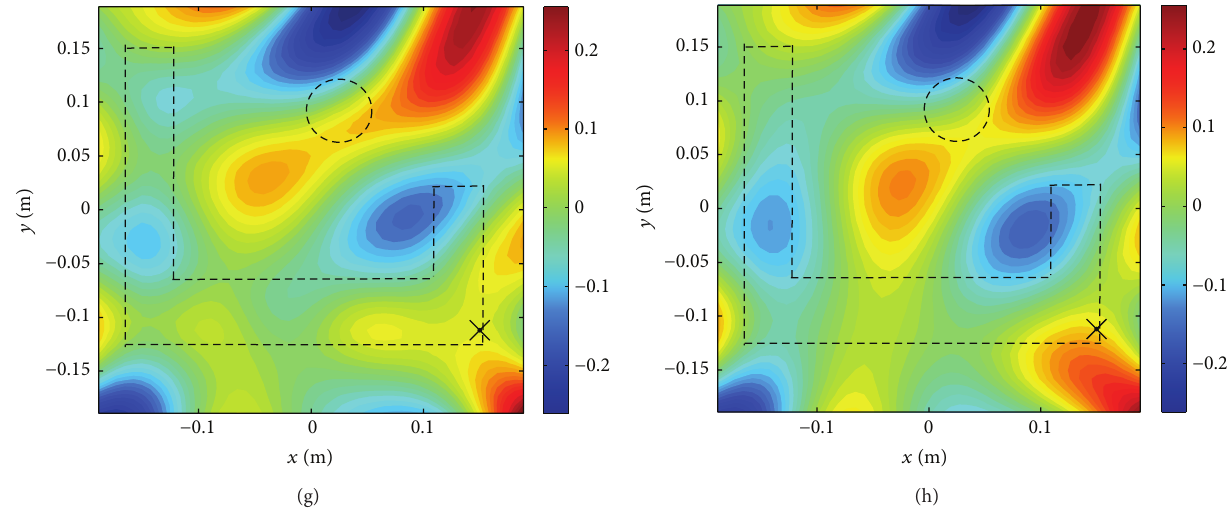
Figure 8: Performance assessment of the field approximation: comparison for the triangular cavity, example 2. ((a), (c)) Real and imaginary parts of total field in the minimum residual pivot point; ((b), (d)) real and imaginary parts of virtual field in the minimum residual pivot point; ((e), (g)) real and imaginary parts of total field in the maximum residual pivot point; ((f), (h)) real and imaginary parts of virtual field in the maximum residual pivot